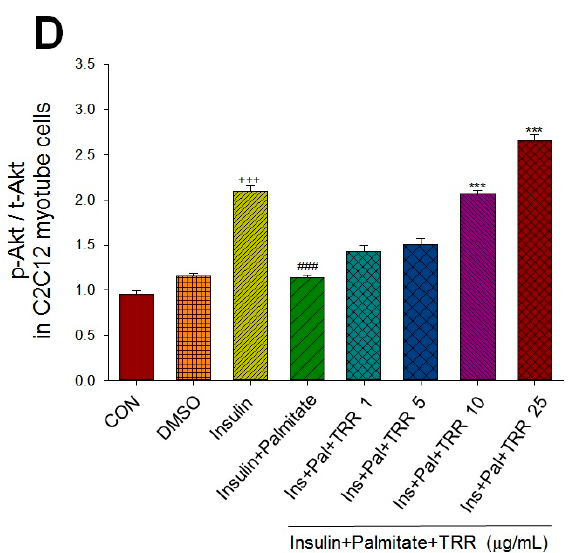
Figure 2. Effects of eburicoic acid (TRR) on the insulin (Ins)-stimulated expression levels of membrane glucose transporter type 4 (GLUT4), the ratio of phospho-5 ′ -adenosine monophosphate kinase (p-AMPK) to total AMPK (t-AMPK), or phospho-Akt (p-Akt)/total Akt (t-Akt) in insulin-resistant C2C12 myotube cells induced by palmitate (Pal). The symbols “+++”, “###” and “***” represent p < 0.001 as respectively compared to the value of the blank control, positive control (insulin) and negative control (insulin + palmitate) using analysis of variance (ANOVA) and with Dunnett’s tests. ( A ) Representative image. ( B – D ) Quantification of the membrane GLUT4 expression levels, the ratio of p-AMPK to t-AMPK, or p-Akt/t-Akt expression levels. CON: Blank control; DMSO: Dimethyl sulfoxide, solvent control.